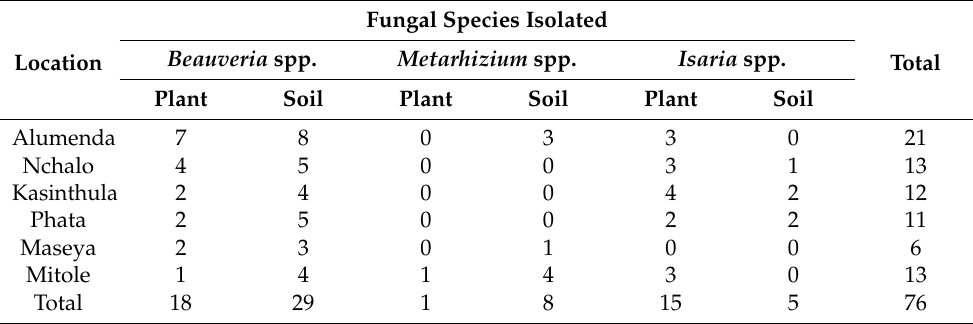
Table 1. Number of Beauveria spp., Metarhizium spp., and Isaria spp. obtained from soils ( n = 60)